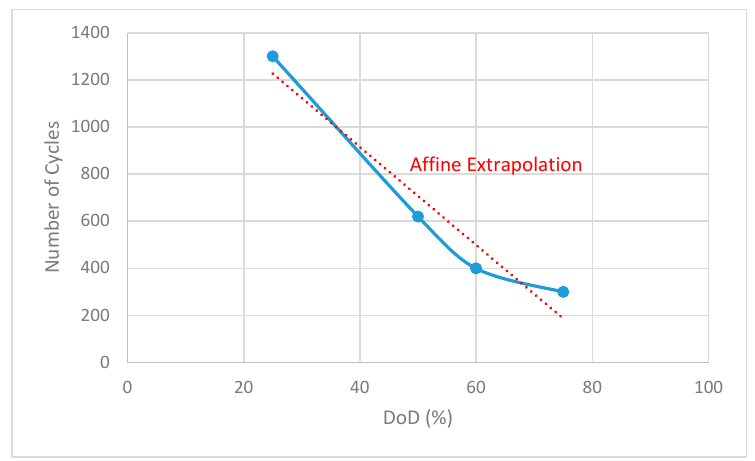
Figure 6. A linear trend extrapolation of SOH according to DOD variation.